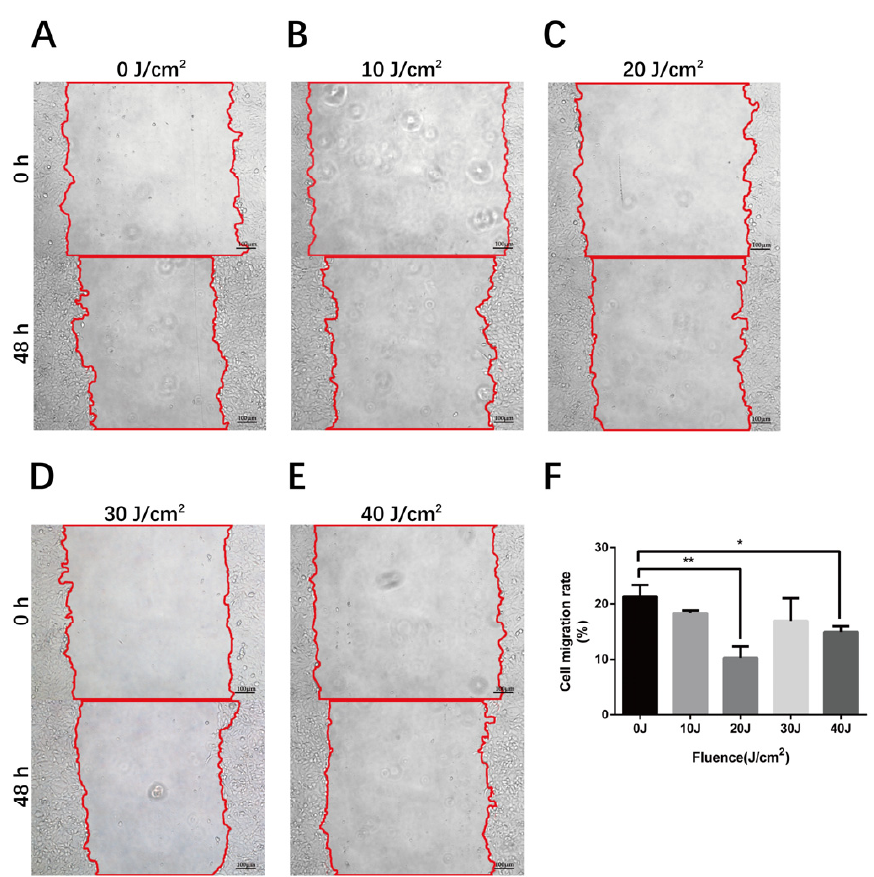
Figure 2. The influence of 590 nm LED on cell migration of HMEC-1. ( A – E ) The wound healing area 48 h after 0–40 J/cm 2 LED irradiation. ( F ) Cell migration rate 48 h after 0–40 J/cm 2 LED irradiation. Results from three independent experiments are presented as means ± SD. *, p < 0.05; **, p < 0.01. Bar, 100 μ m.